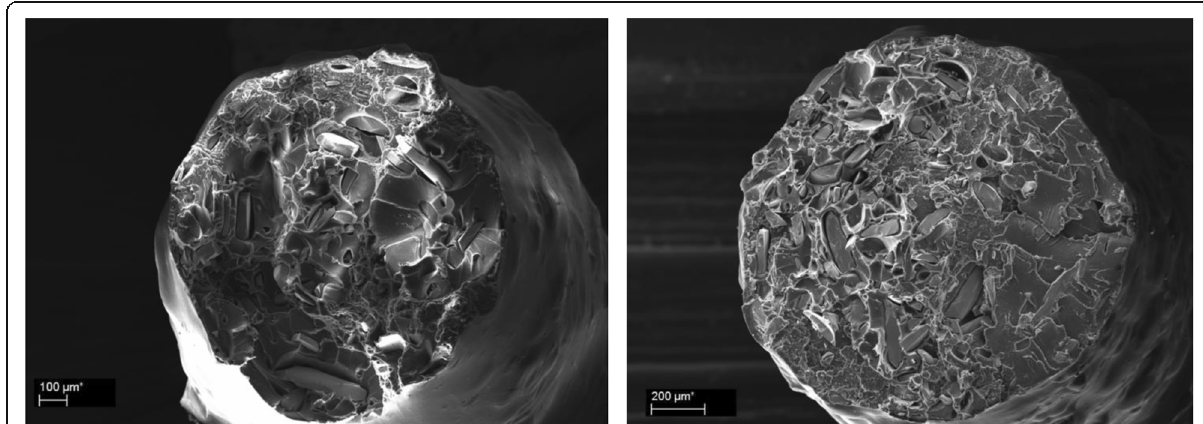
Fig. 6 Fracture surfaces of PEEK_25NdFeB (left) and PEEK_50NdFeB (right)